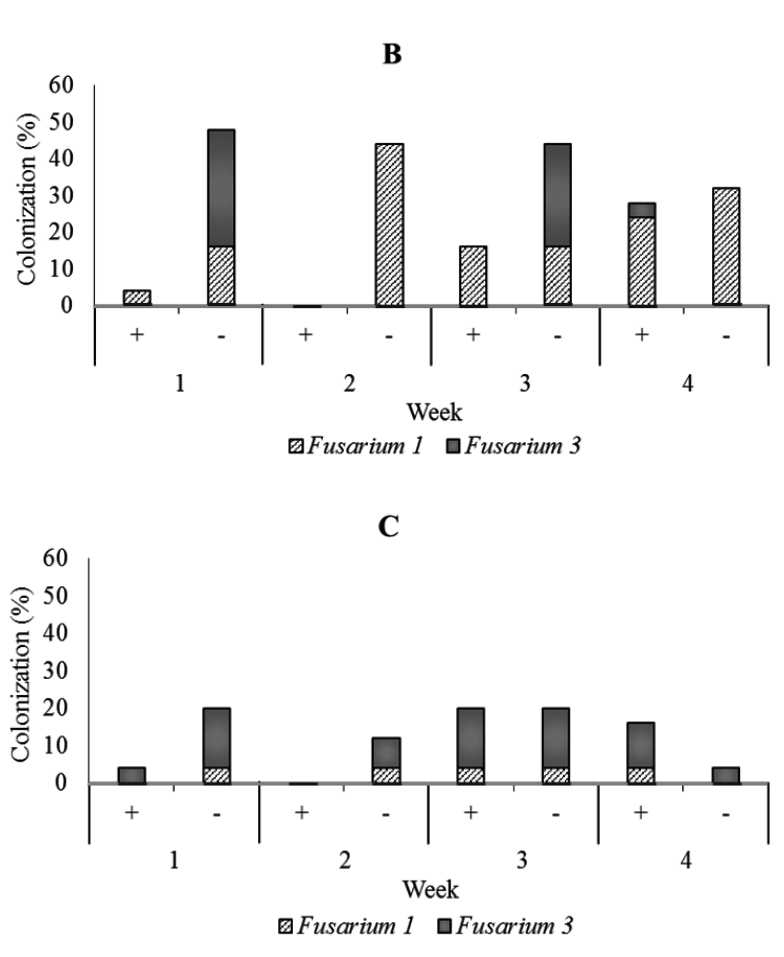
Fig. 4. Dominant fungal endophytes colonizing stem (B) and root tissues (C) of two-month-old seedling at one, two, three, and four weeks after Trichoderma asperellum inoculation through foliar spraying. +, with T. asperellum ; -, without T.